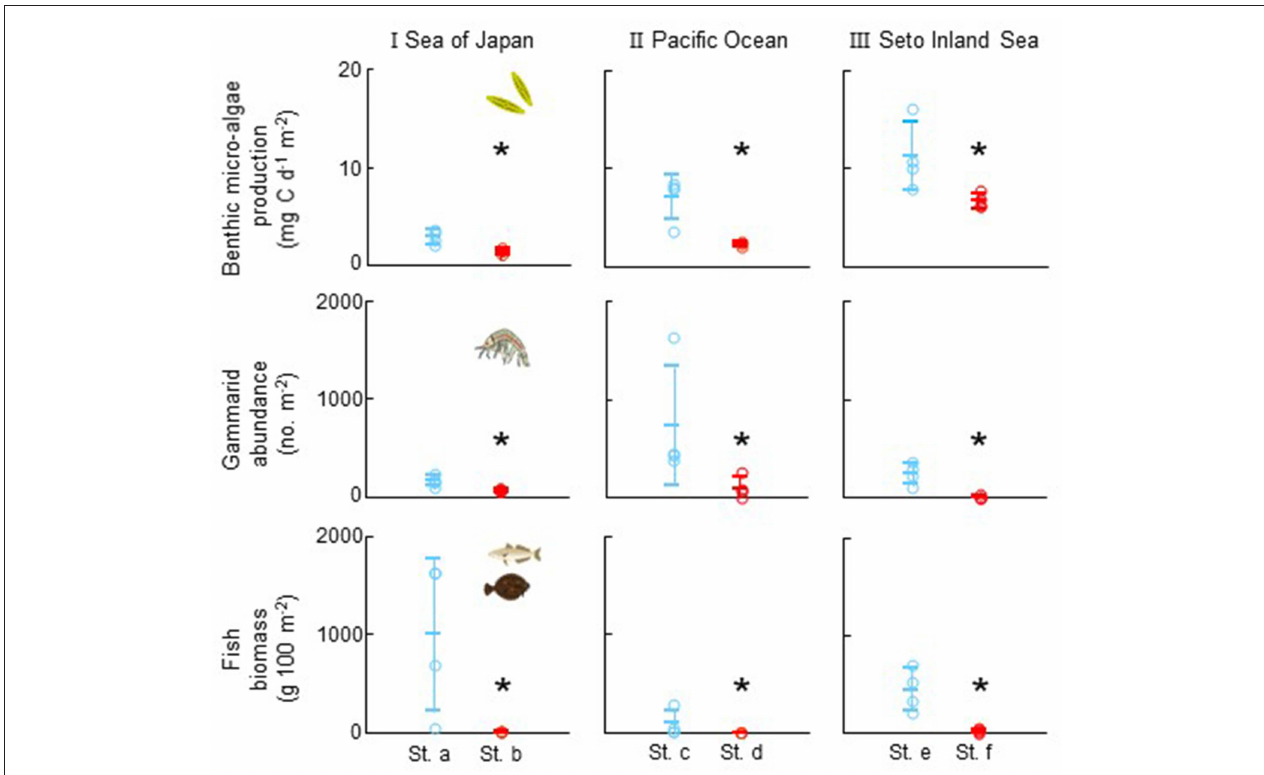
FIGURE 3 | Comparison of benthic microalgae production (top) , abundance of gammarids (as dominant primary consumer and also as major prey organisms for fish: middle) and fish biomass (bottom) between the two stations with different levels of 222 Rn concentrations as an indicator of SGD within each site (I: Sea of Japan, II: Pacific Ocean, and III: Seto Inland Sea). Circles indicate each data and bars show mean and standard deviation. Asterisk shows significant difference within each site (Mann–Whitney U -test, p < 0.05 for all).